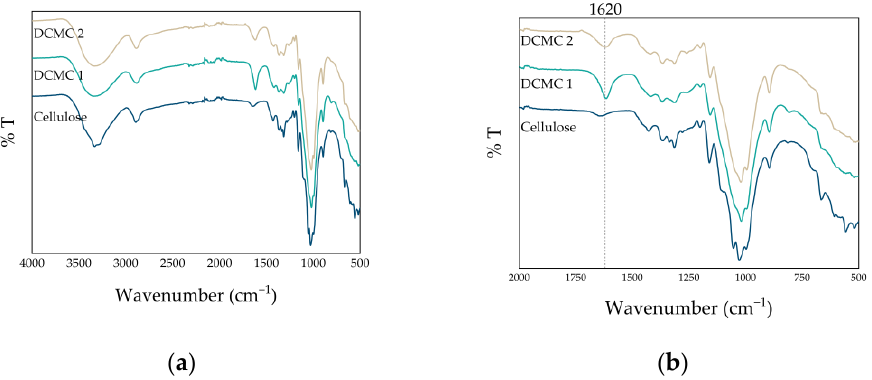
Figure 2. ( a ) Full FTIR spectra; ( b ) zoom-in region for the carbonyl stretching vibrations. Table 3. FTIR peak assignments of